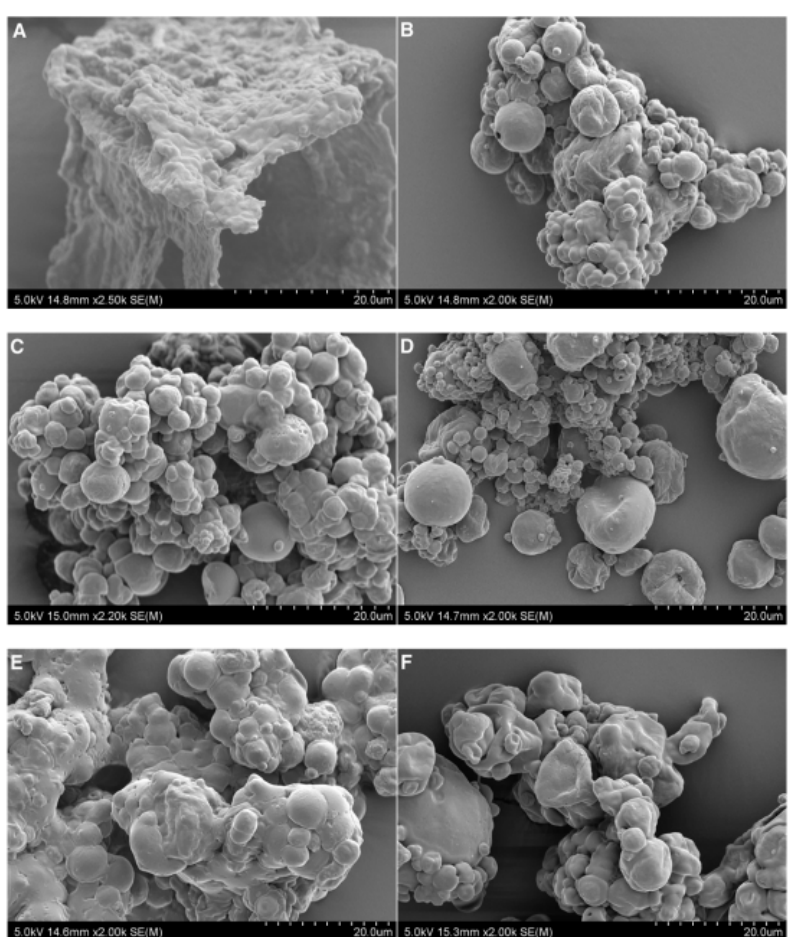
Figure 3. SEM images of AWW powders. The following data represents powder treatment as well as mean particle size ± standard deviation of powder. ( A ) Freeze-dried AWW, 1.57 ± 0.29 µ m; ( B ) Maltodextrin with a 10–12 dextrose equivalence (MD 10–12 DE), 4.3 ± 2.36 µ m; ( C ) MD 17–19 DE, 4.6 ± 1.75 µ m; ( D ) Acacia gum, 4.6 ± 3.39 µ m; ( E ) Lactose, 4.14 ± 1.41 µ m; ( F ) WPC, 4.4 ± 2.23 µ m. Samples were randomised images of what was seen under the SEM for the various parameters. Samples ( B ) to ( F ) were subjected to spray drying conditions of 140 ◦ C, 5.8 g / min feed flow rate,